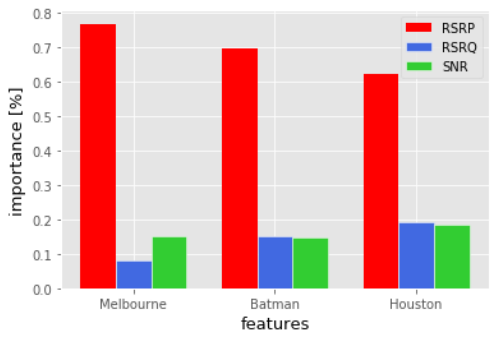
Figure 11. Variable